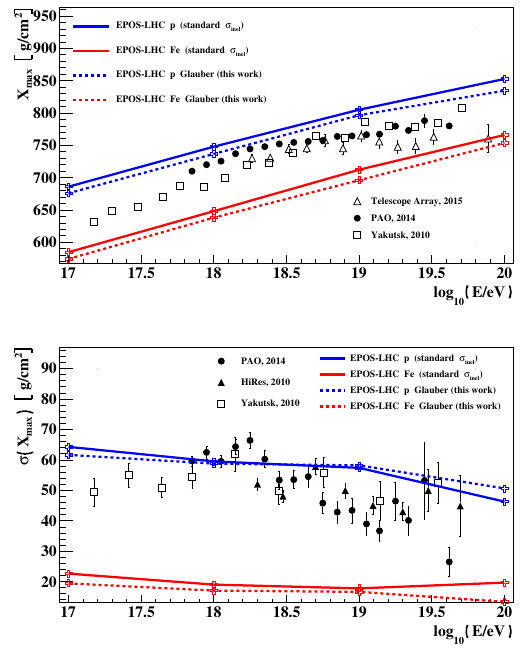
Figure 4. (top): Position of X max simulated using EPOS-LHC model with di ff erent σ inel . Results for our Glauber calculations (dotted line) are compared original σ inel in EPOS-LHC model (solid line), (bottom): σ parameter of obtained X max values.